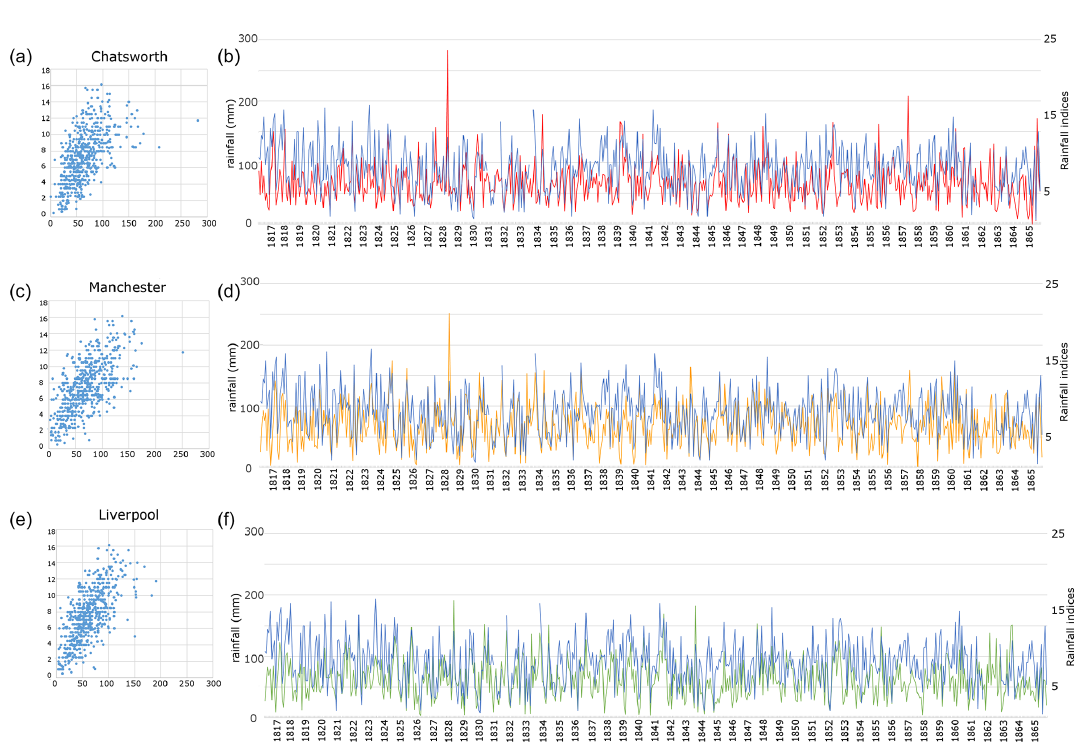
Figure 5. (a) Correlation between Chatsworth rainfall and the Trentham index series ( r = 0 . 579; p = < 0 . 001); (c) Manchester rainfall and Trentham index series ( r = 0 . 664; p = < 0 . 001); (e) Liverpool rainfall and Trentham index series ( r = 0 . 667; p = < 0 . 001). (b, d, f) Comparison of the Trentham rainfall index (blue) alongside instrumental rainfall from Chatsworth (red), Manchester (orange) and Liverpool (green)